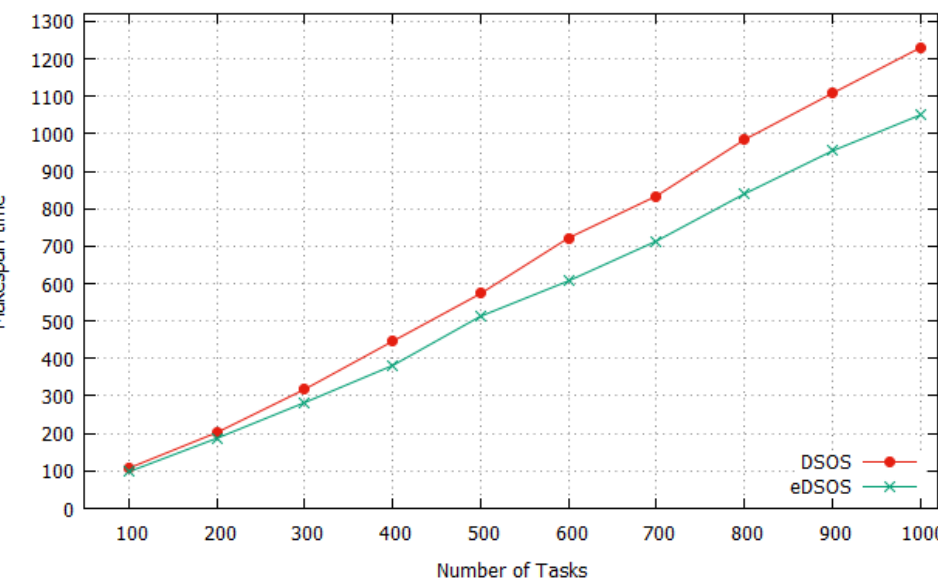
Figure 6. Makespan for the dataset with the uniform distribution.